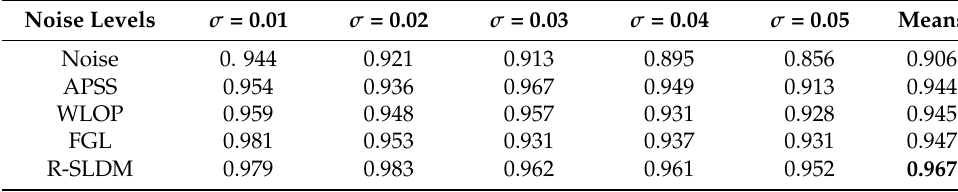
Table 3. SSIM of five different denoising algorithms for Daratech models.